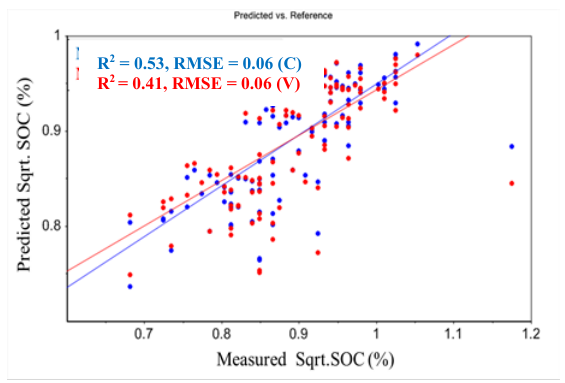
Figure 4. Scatter plot of SOC in calibration dataset The statistical indices of the validation dataset like R 2 , RMSEP and RPD were employed to assess the prediction accuracy of